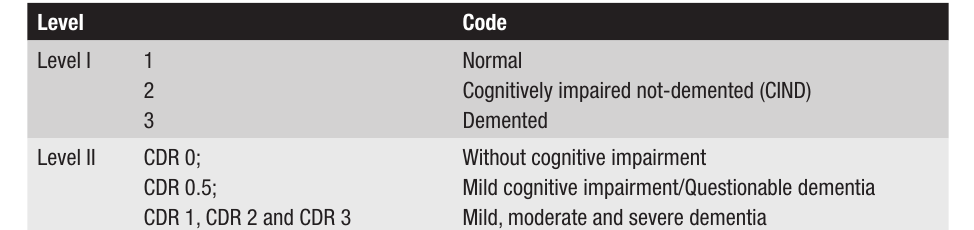
CIND, cognitively impaired